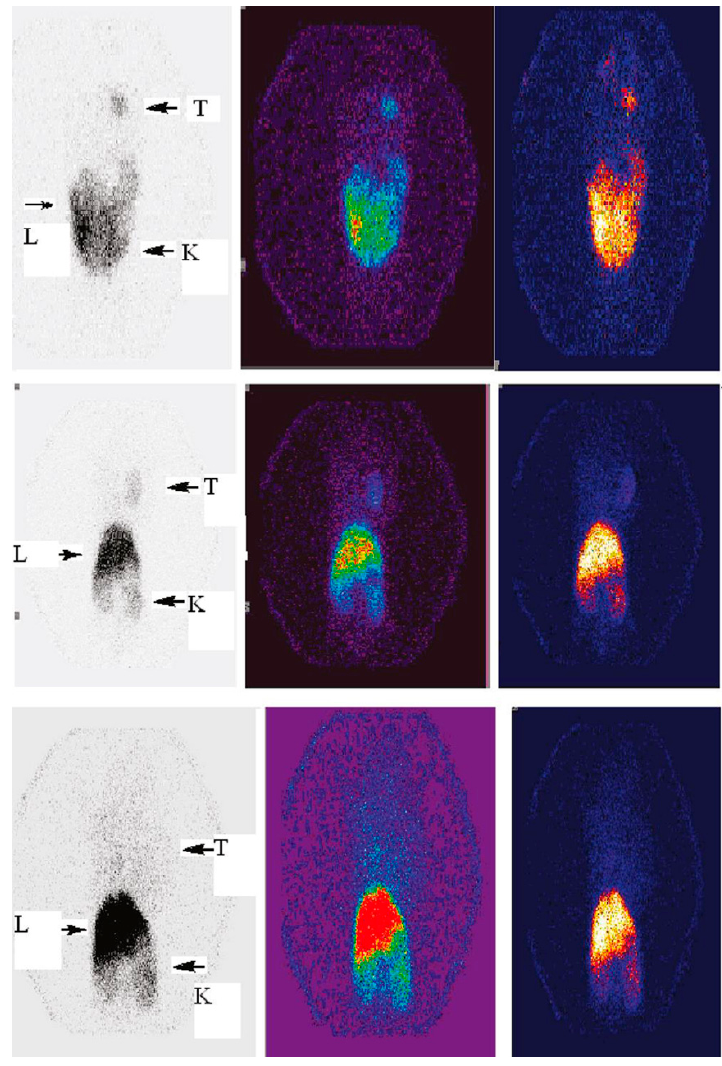
Figure 1. Micro-SPECT images of KB-bearing nude mice at 4 h: T, tumor; L, lungs; K, kidney (( upper ) 99m Tc-G5-Ac-pegFA-DTPA, ( middle ) 99m Tc-G5-Ac-FA-DTPA, ( lower ) 99m Tc-G5-Ac-DTPA) (adapted from [66], Journal of Medicinal Chemistry, 2010).